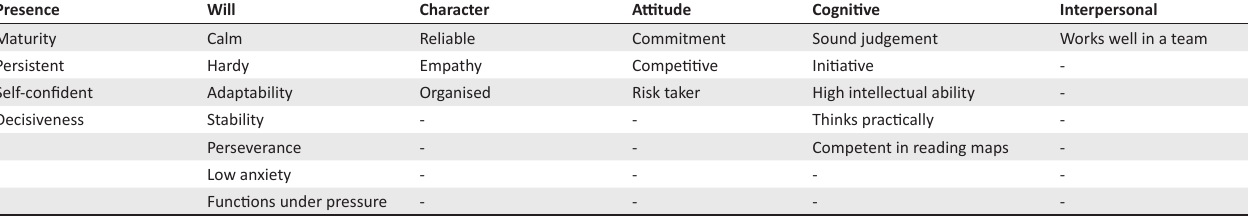
TABLE 1: Attributes and skills related to military career success.